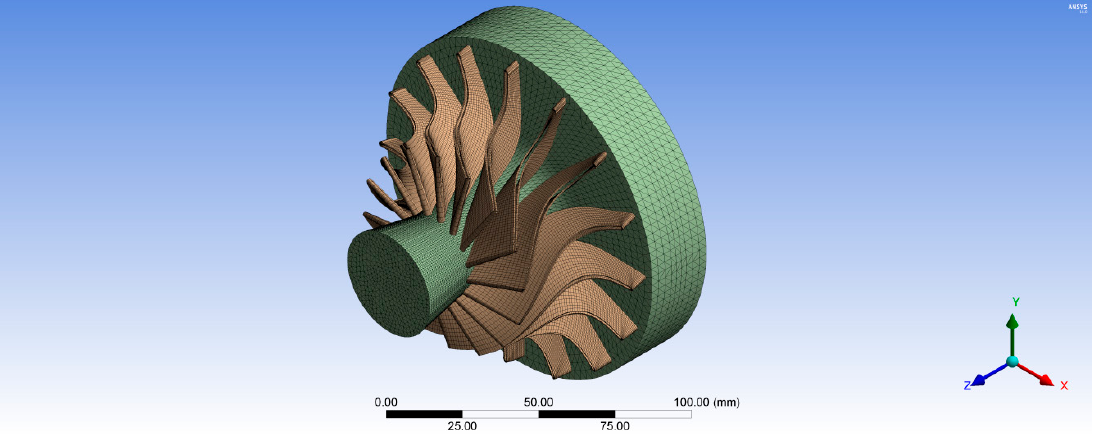
Figure 8. Three-dimensional structural model for the turbine including the composite rotor blades and the stainless steel wheel hub.